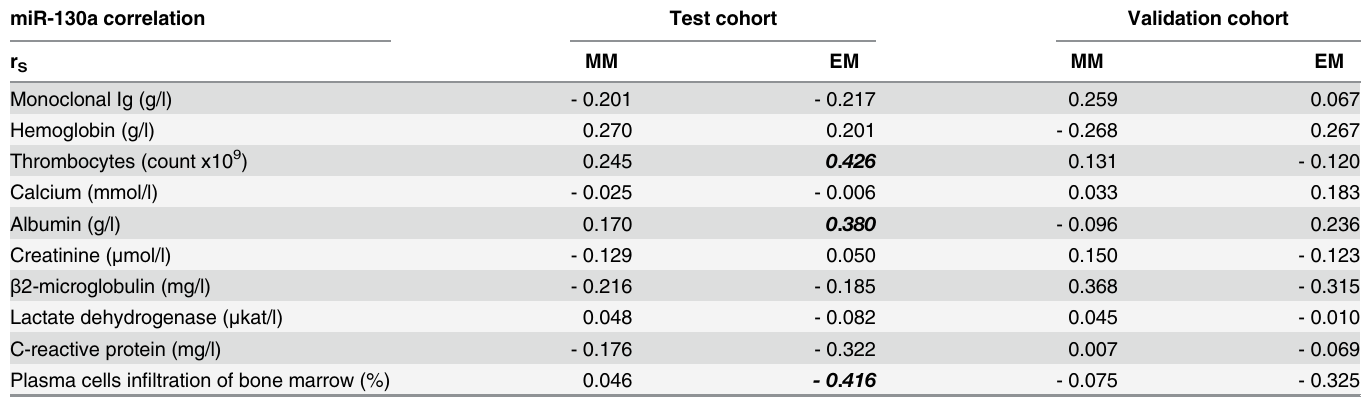
Table 4. Correlation of serum miR-130a levels with clinically important biochemical parameters. Data are presented as coefficients of correlation. Sta- tistically significant correlations are marked in bold and